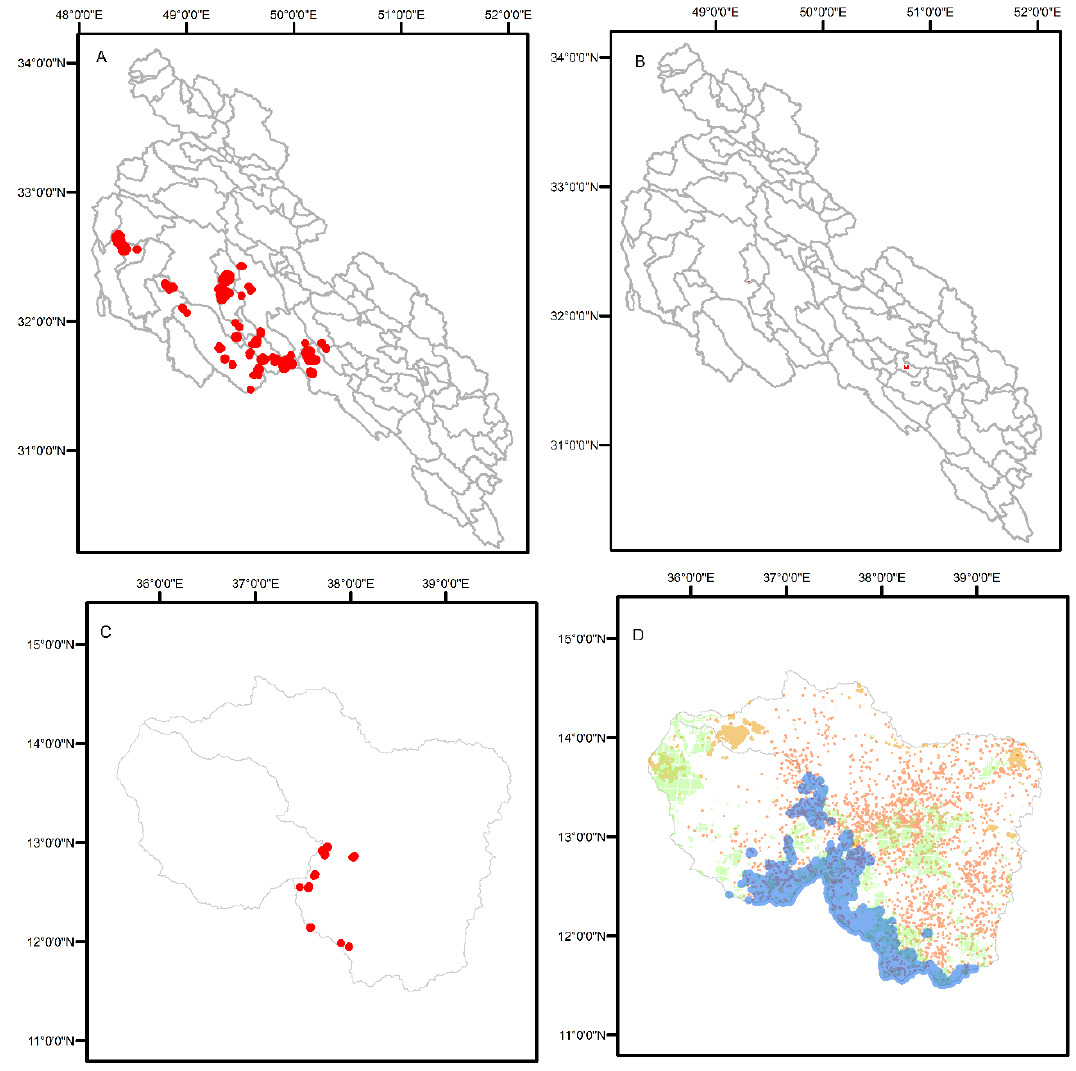
Figure 6. Leverage areas for two types of sediment management interventions First type ( A , C ): Hotspots map for planning ad-hoc sediment management ( A ) at beginning of December in Karun and ( C ) in May in Upper Atbara. Global gridded monthly rainfall depth [55] was used. Second type: ( B ) Permanent hotspots in the proximity of rainfall measurement stations at the end of dry season (September) in Karun (rainfall depth per month, 29 stations, 15 years). ( D ) Hot spots (HS) or emerging hotspots (EHS; 2000–2016) maps of rainfall (blue HS, rainfall dataset [56]), connectivity (red HS), soil erodibility (brown HS), and vegetation (green EHS) in Upper Atbara at the beginning of rainy season (May).